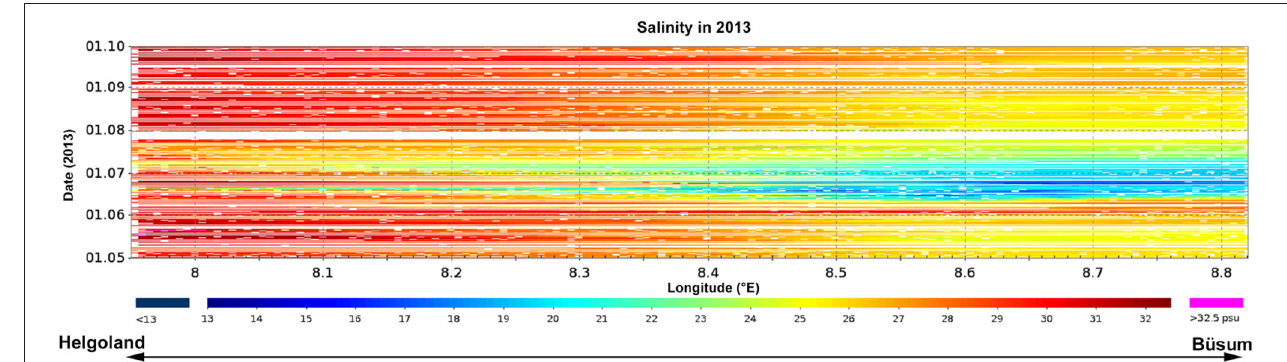
FIGURE 3 | A Hovmöller diagram combining salinity observations from all ferry cruises between Büsum and Helgoland during May to September